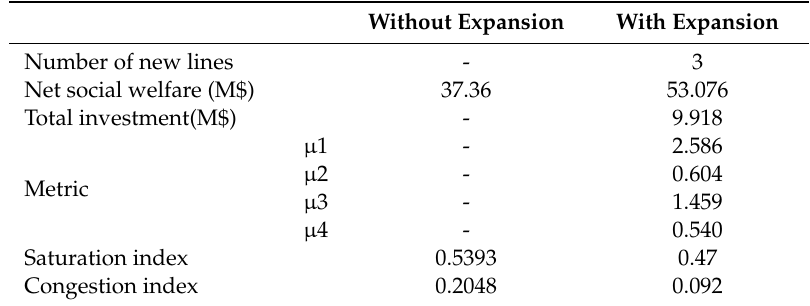
Table 7. Summary of results case study